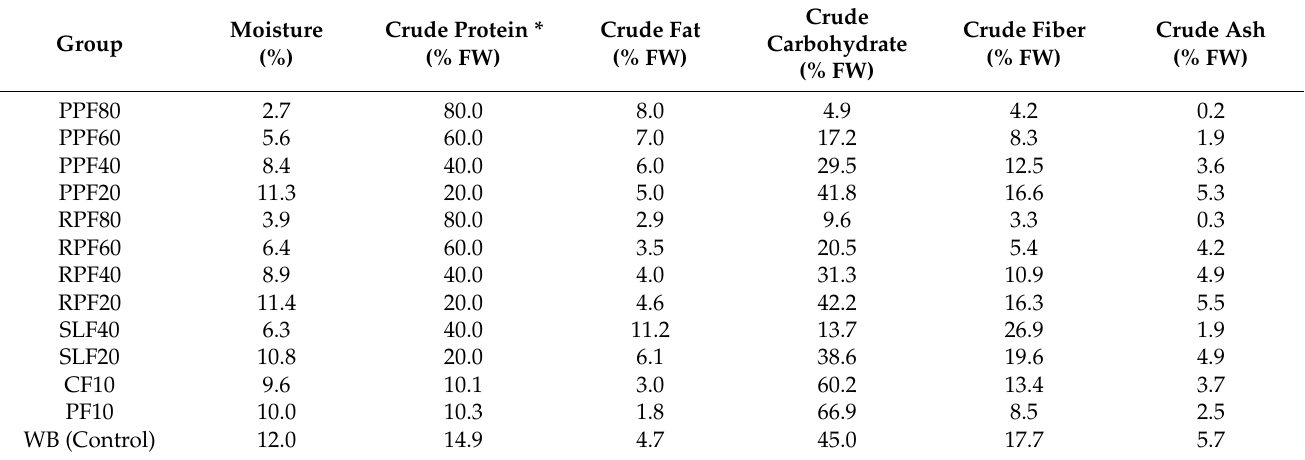
Table 2. Nutritional composition of the diets on a fresh weight (FW) basis (%) used for Tenebrio molitor larvae